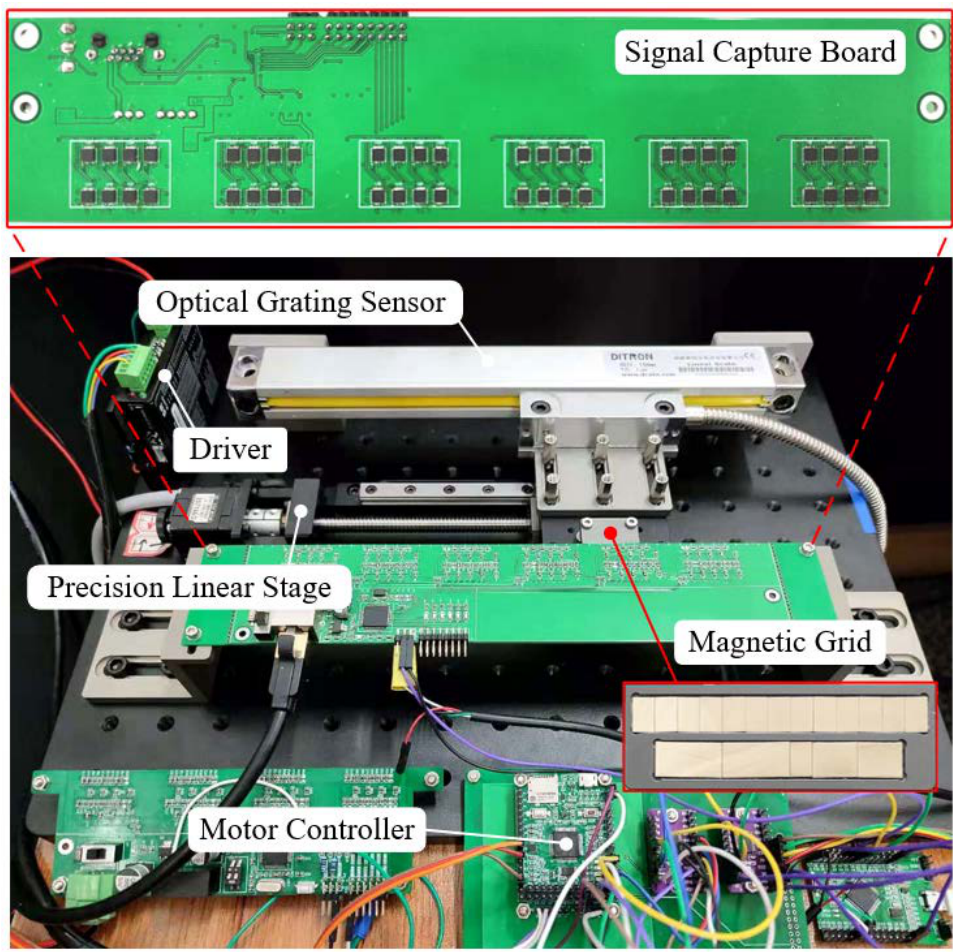
Figure 8. Experimental test platform. Table 2. Experimental equipment parameters.